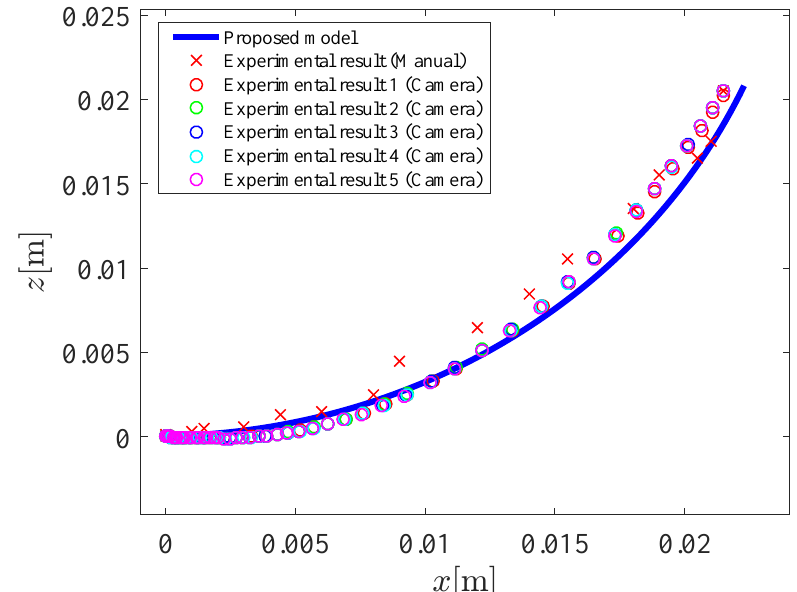
Figure 14. The coordinate values x and z of the tip of the micro-hand ( P 1 = P 2 = 0kPa, P 3 = 0 kPa–250 kPa).